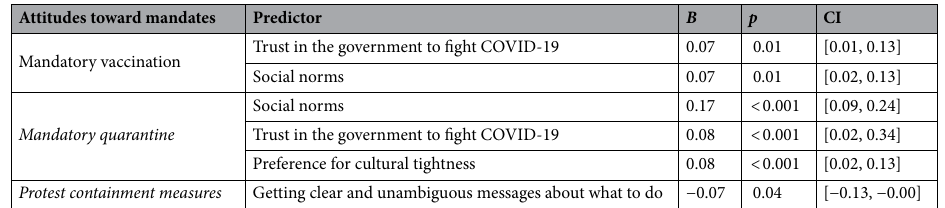
Table 2. Predictors of attitudes toward behavioral